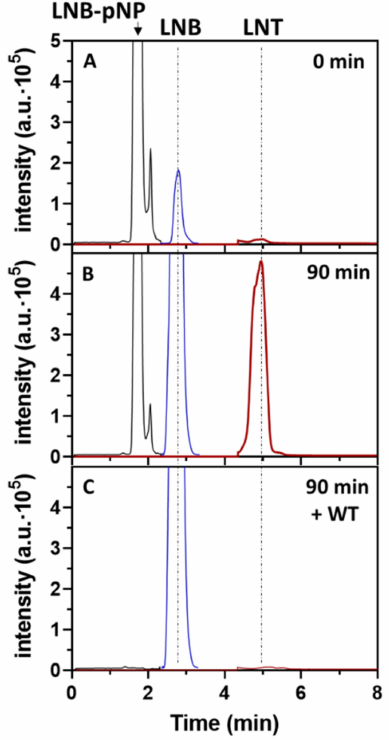
Figure 5. HPLC-MS monitoring of the transglycosylation reaction catalyzed by LnbB W394F. Reac- tion conditions: 1 µ M enzyme, 2.5 mM LNB- p NP, 200 mM lactose, citrate-phosphate buffer pH 4.5. ( A ) t = 0 min; ( B ) t = 90 min, followed by heat inactivation; ( C ) After addition of wt LnbB (1 µ M) for 15 min. Detection by EI-MS. Lactose acceptor is not shown since it is in large